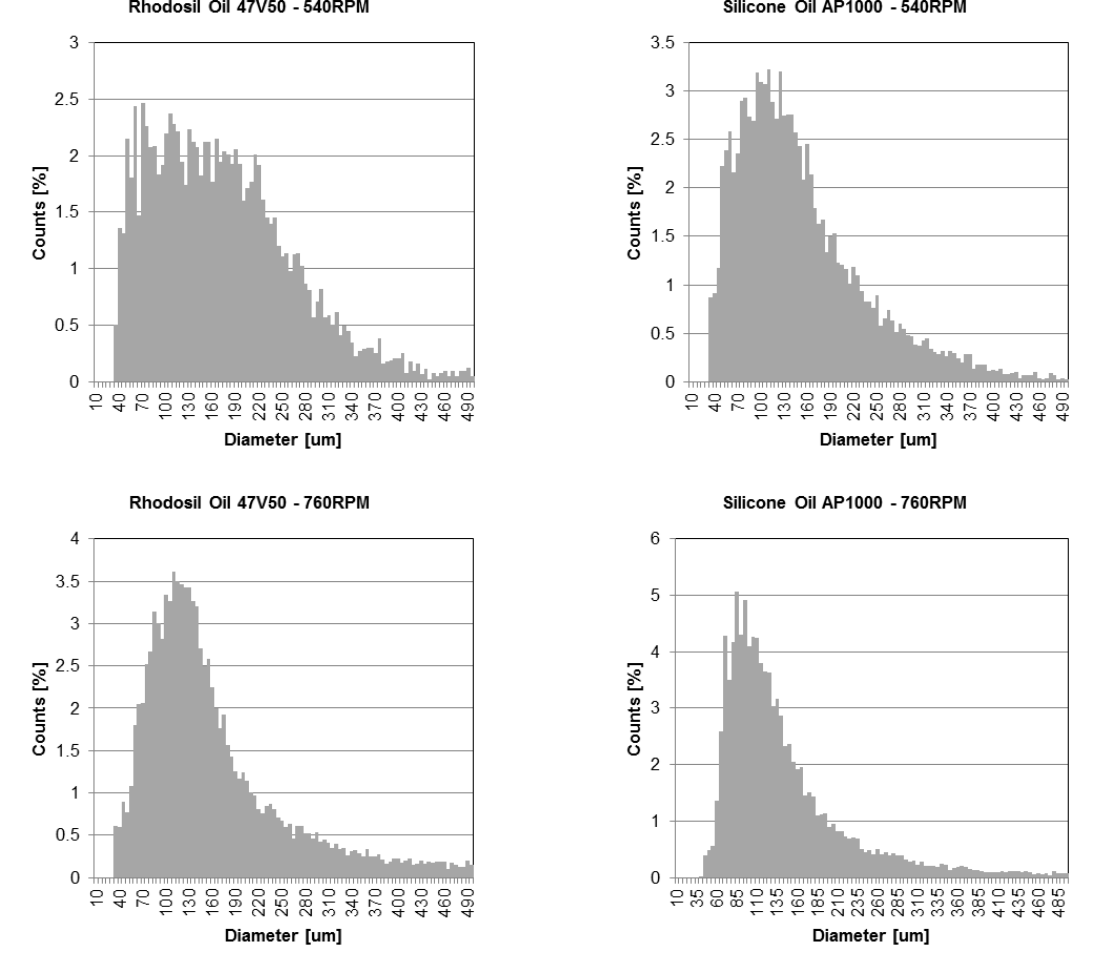
Fig. 6. Histogram of stabile dispersion of disintegrated Rhodosil Oil 47V50 and Silicone Oil